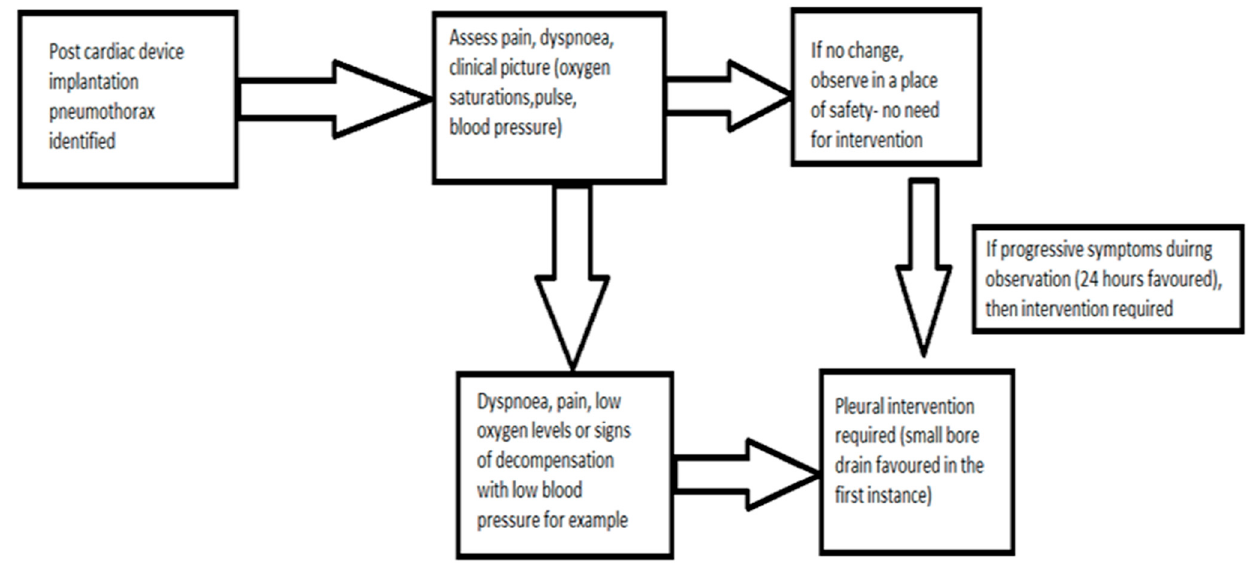
Figure 2. Suggested flow chart for assessment and management of pneumothorax post cardiac device implantation.